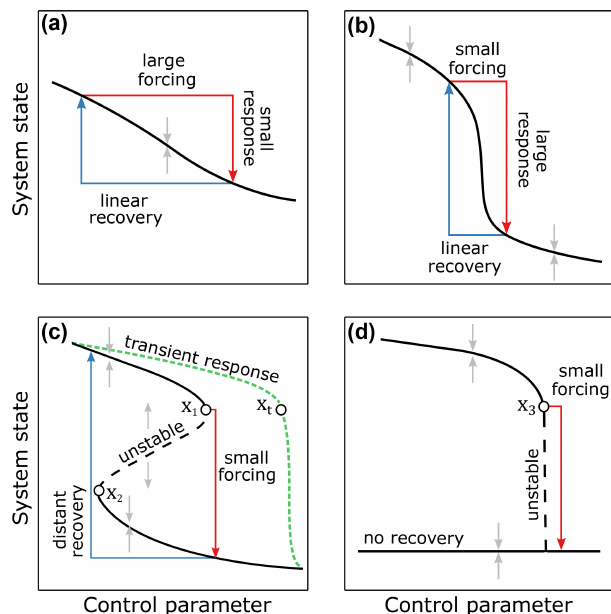
Figure 1. Possible range of behaviours for a system state (e.g. ice flux) in response to perturbations in a control parameter (e.g. ocean temperature). A system can (a) respond to a perturbation in a lin- ear way that is directly recoverable with a reversal of the forcing; (b) have a large response to a small perturbation that is still directly recoverable; (c) have a large response to a small perturbation that is irreversible (hysteresis behaviour); and (d) have a large response that is irreversible for any change in the tested range of the control parameter, a behaviour we refer to as permanently irreversible (no recovery possible even if forcing is reversed well below the initial level). Tipping points are crossed only in panels (c) and (d) and are indicated by x 1 , x 2 and x 3 . Panel (c) also shows a transient response in which the system state lags behind changes in the control param- eter as is the case for ice sheets and thus crosses the irreversible system state at a later point, x t